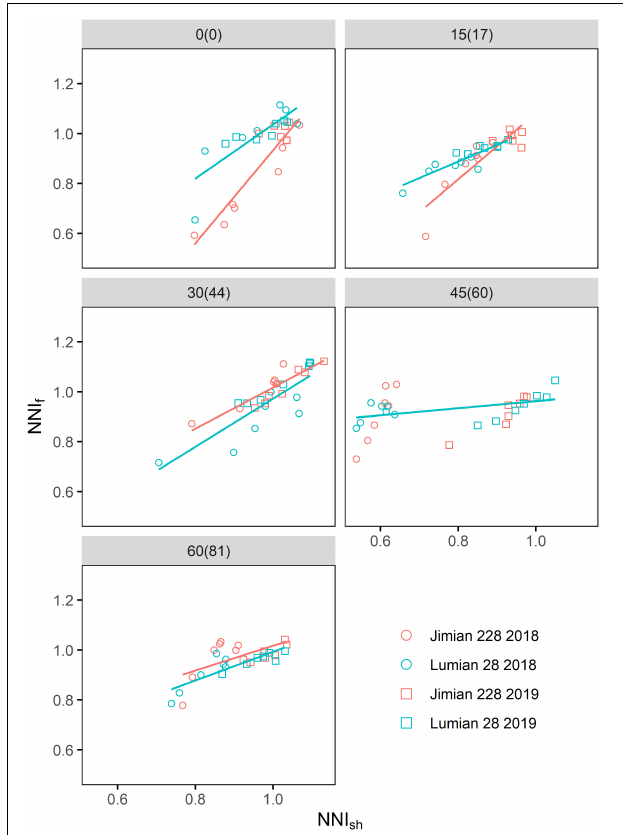
FIGURE 6 | The relationships between the shoot nitrogen nutrition index (NNI sh ) and fruits nitrogen nutrition index (NNI f ) for the two cotton cultivars at each sampling date. The NNI f (NNI sh ) is calculated as the ratio between the actual fruits (shoot) N concentration and the critical fruits (shoot) N concentration. Points shown for the mean values of the three replicate plots. The values without and with brackets are the days after flowering corresponding to different sampling dates in 2018 and 2019, respectively. The red and blue solid lines represent significant linear relationships ( P < 0.05) for Jimian 228 and Lumian 28 across the 2 years, respectively; non-significant relationships are not shown ( P >